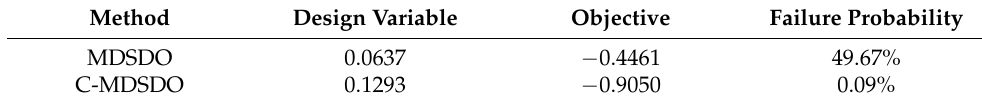
Figure 10. The uncertainty influence on state trajectories under C-MDSDO.